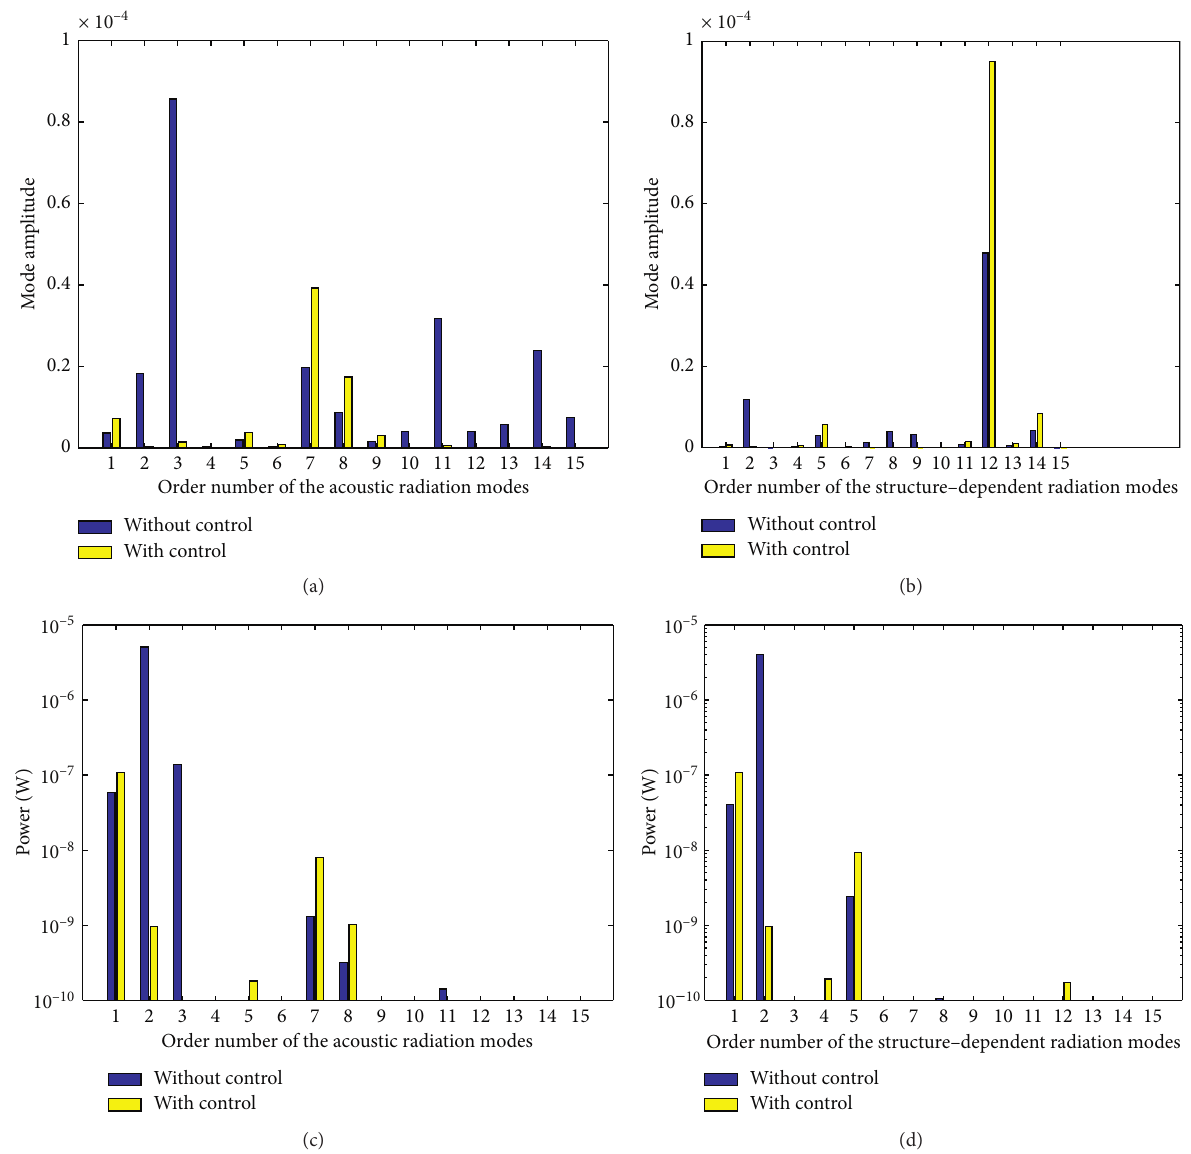
Figure 7: Amplitude and sound power of the a -modes and s -modes at resonance frequency (276 Hz). (a) Amplitude of the a -modes. (b) Amplitude of the s -modes. (c) Sound power of the a -modes. (d) Sound power of the s